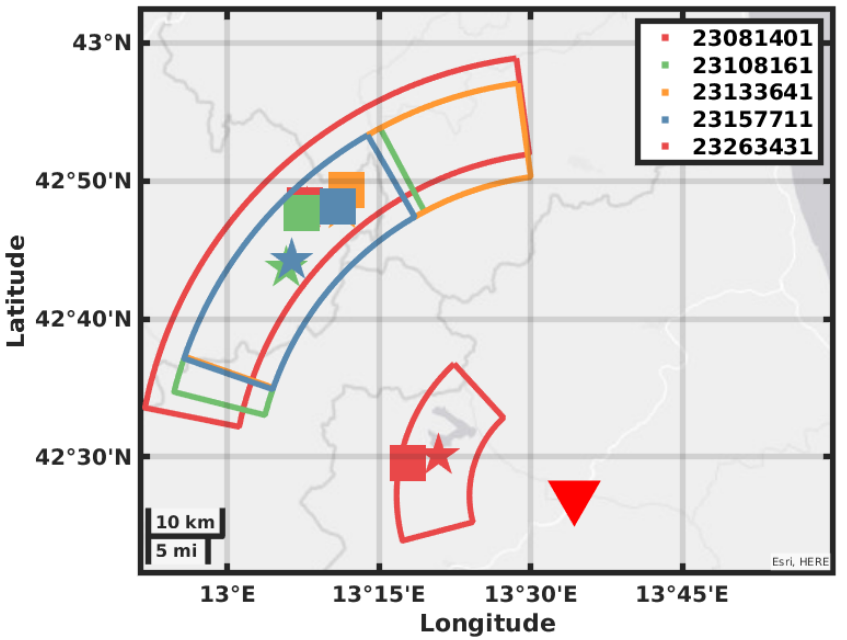
Figure 9. Map showing the GIGS station location, the earthquakes located by the INGV in solid squares, the earthquakes located using the GIGS station and the relative location error in polar coordinates.